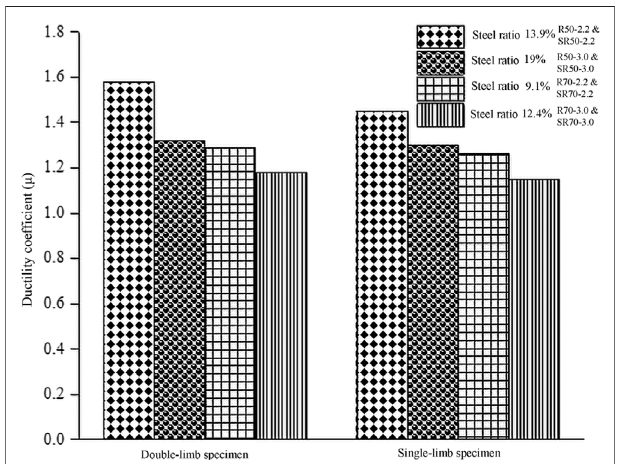
FIGURE 9 | Ductility coef fi cient of specimens.